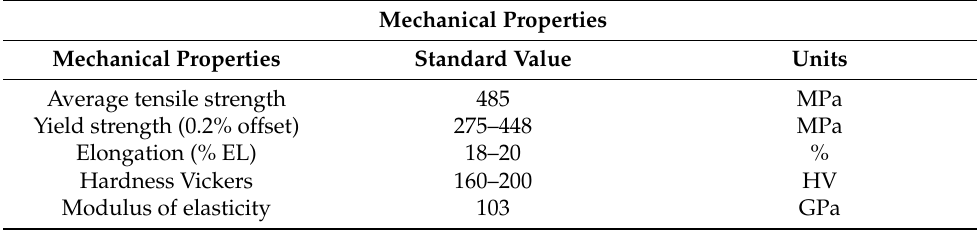
Table 2. The mechanical properties of the titanium alloy grade